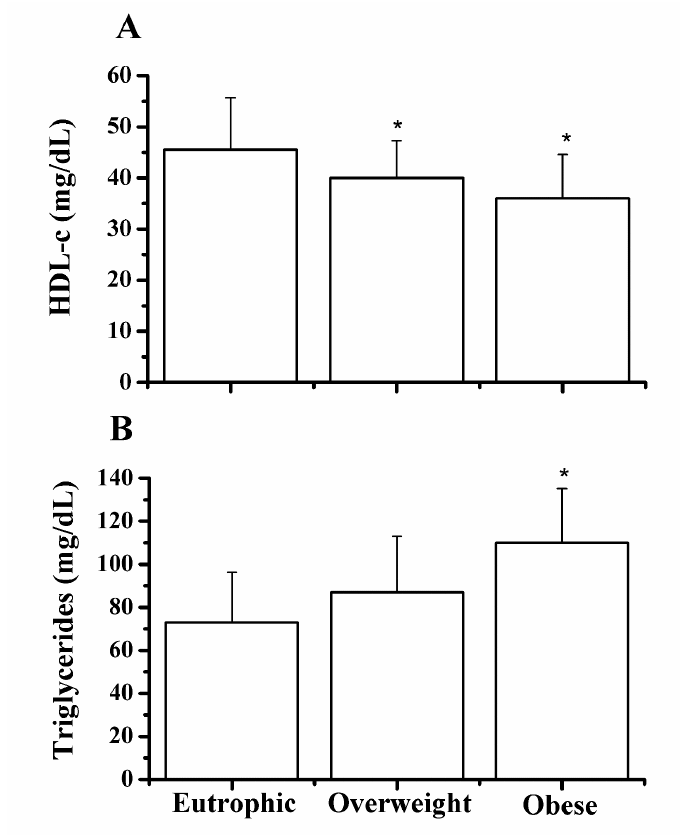
Figure 2. Serum lipid profile. (A) High-density lipoprotein cholesterol (HDL-c). (B) Triglycerides. Data expressed as mean ± standard deviation. Eutrophic (n = 36). Overweight (n = 34). Obese (n = 24).*, significantly different from eutrophic individuals ( p <